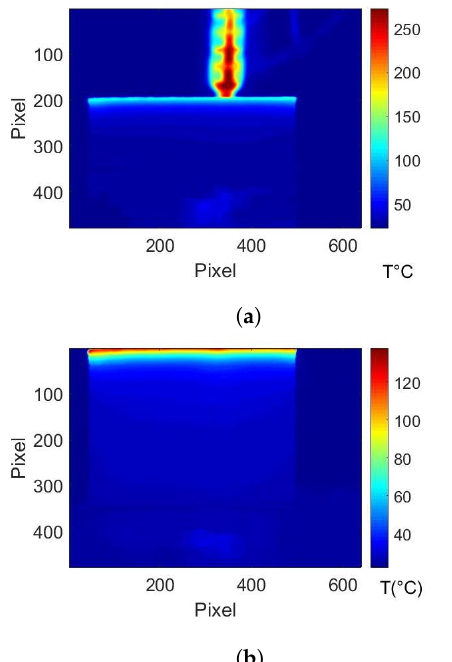
Figure 5. Numerical path of the extruder: ( a ) Path of the extruder over the sensor, ( b ) Path of the extruder to manufacture the part.